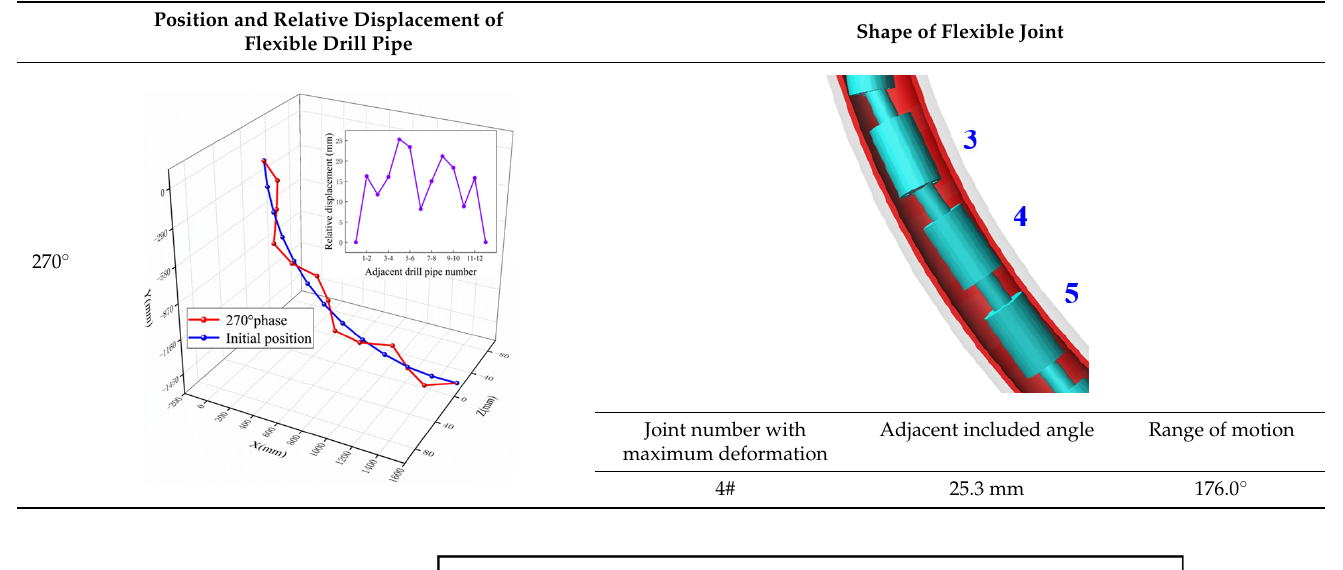
10 of 18 Table 3. Flexible joint geometry at different moments. Position and Relative Displacement of Flexible Drill Pipe